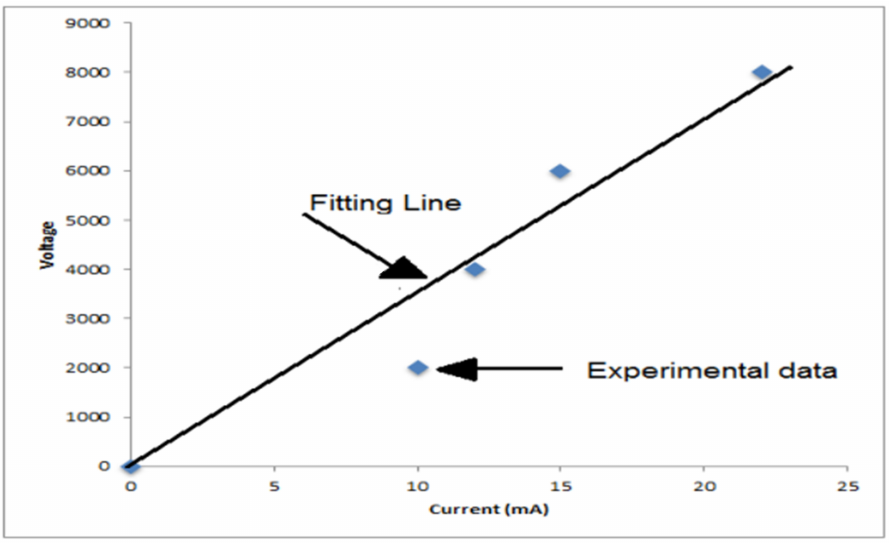
Figure 12. Tree resistance measurement.